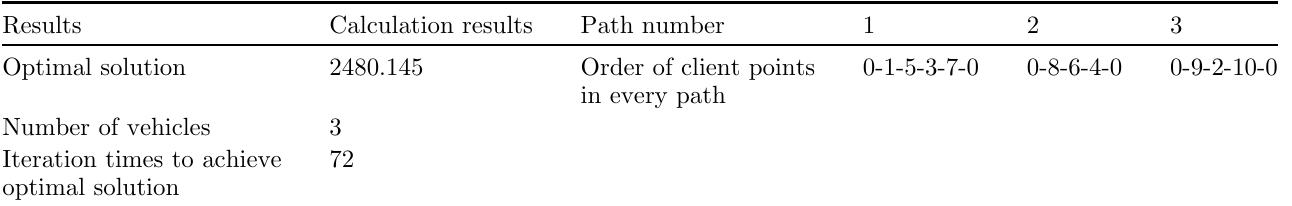
Table 3. Optimal results and